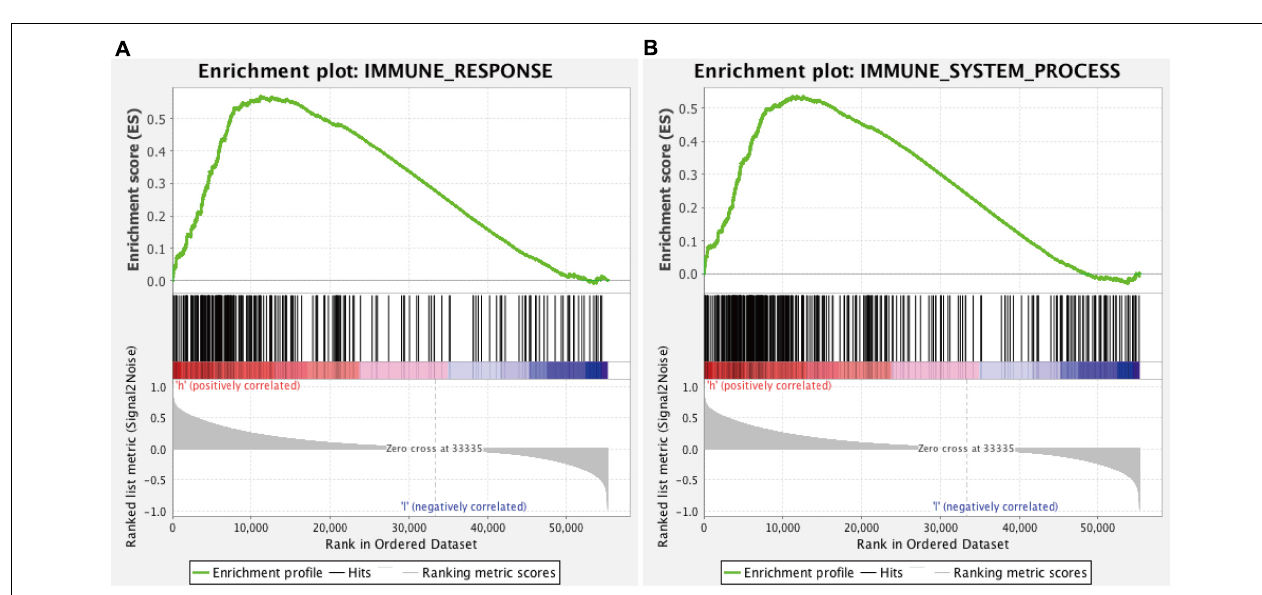
FIGURE 7 | Expression profile of six immune-related lncRNAs in the signature with different glioma grades.